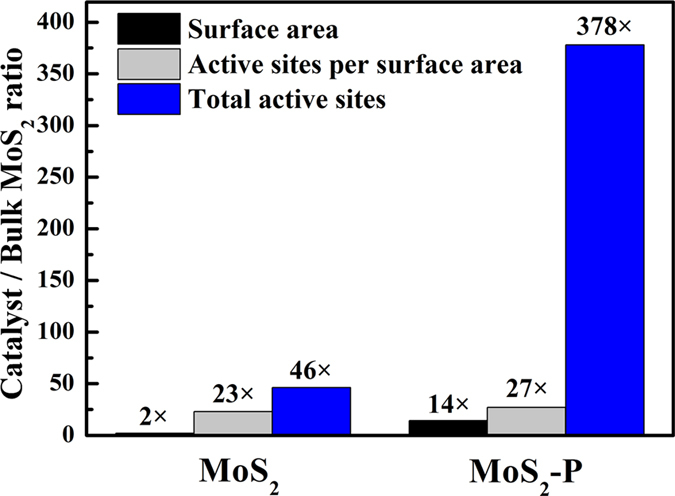
Ratios of surface area, active sites per surface area and total active sites of MoS2 and MoS2-P versus the bulk MoS2.